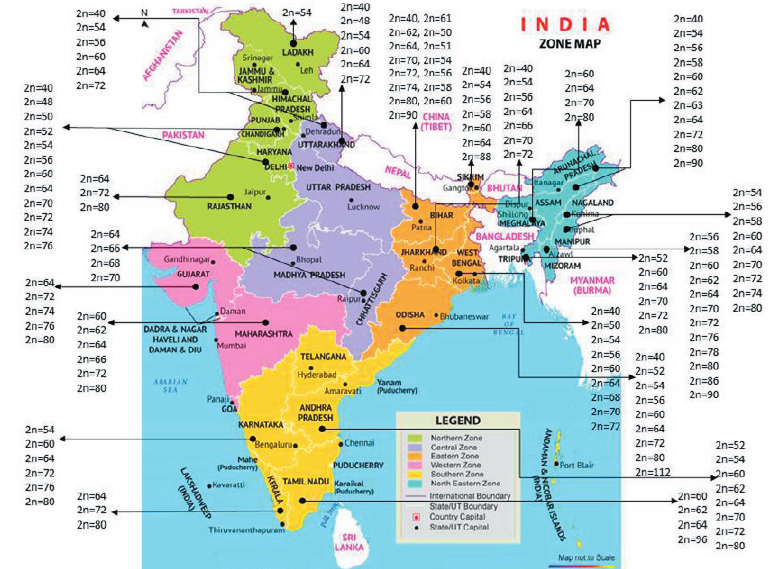
Figure 3. Superimposed map showing distribution of S. spontaneum cytotypes (so far reported) in different states of